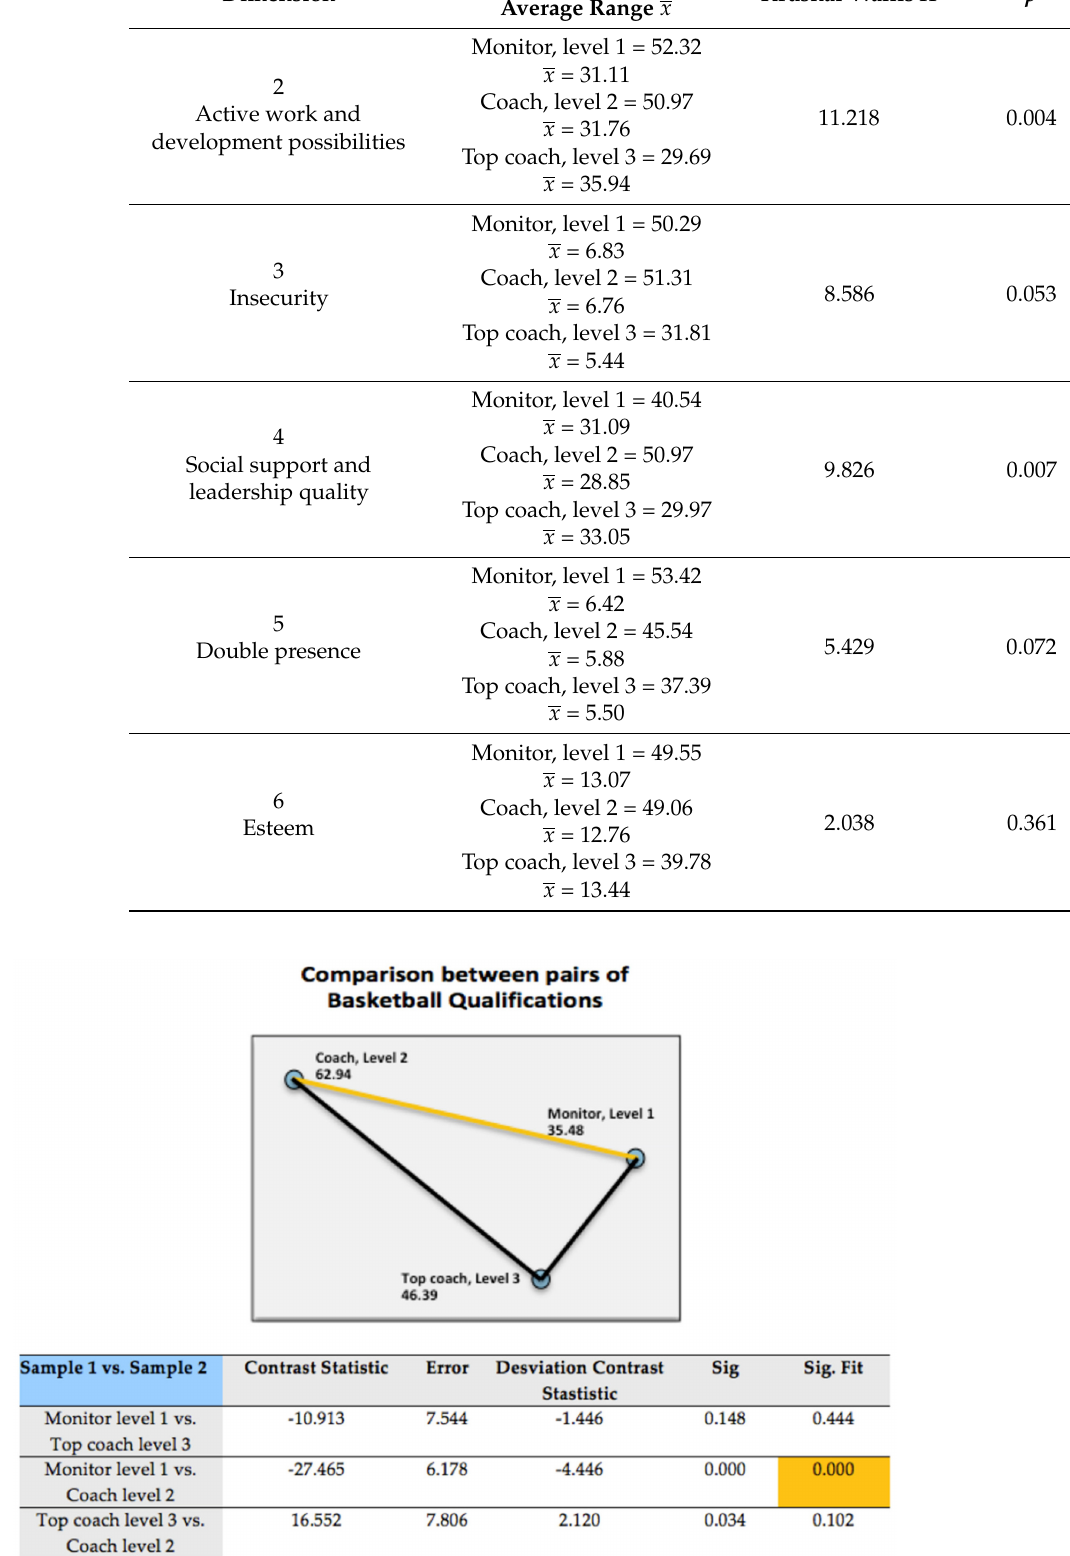
Figure A7. Comparison between pairs of the Psychosocial Demands dimension as a function of basketball